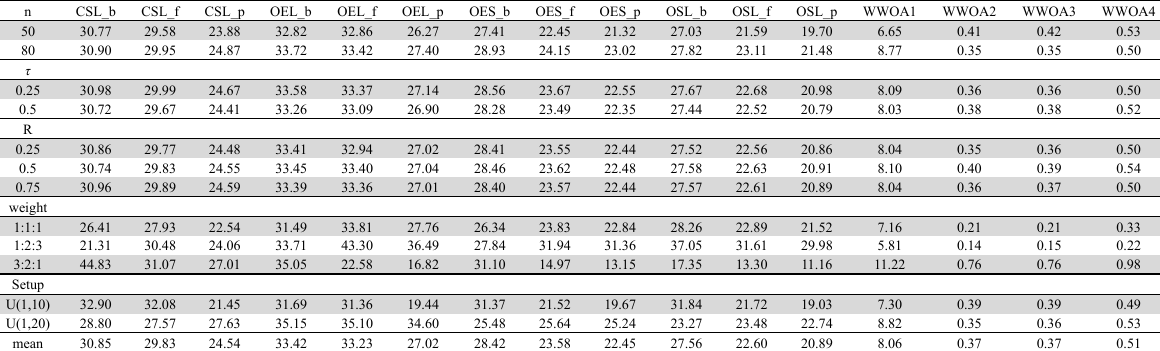
Summary of AEP of 12 heuristics and 4 WWO algorithms for large n n